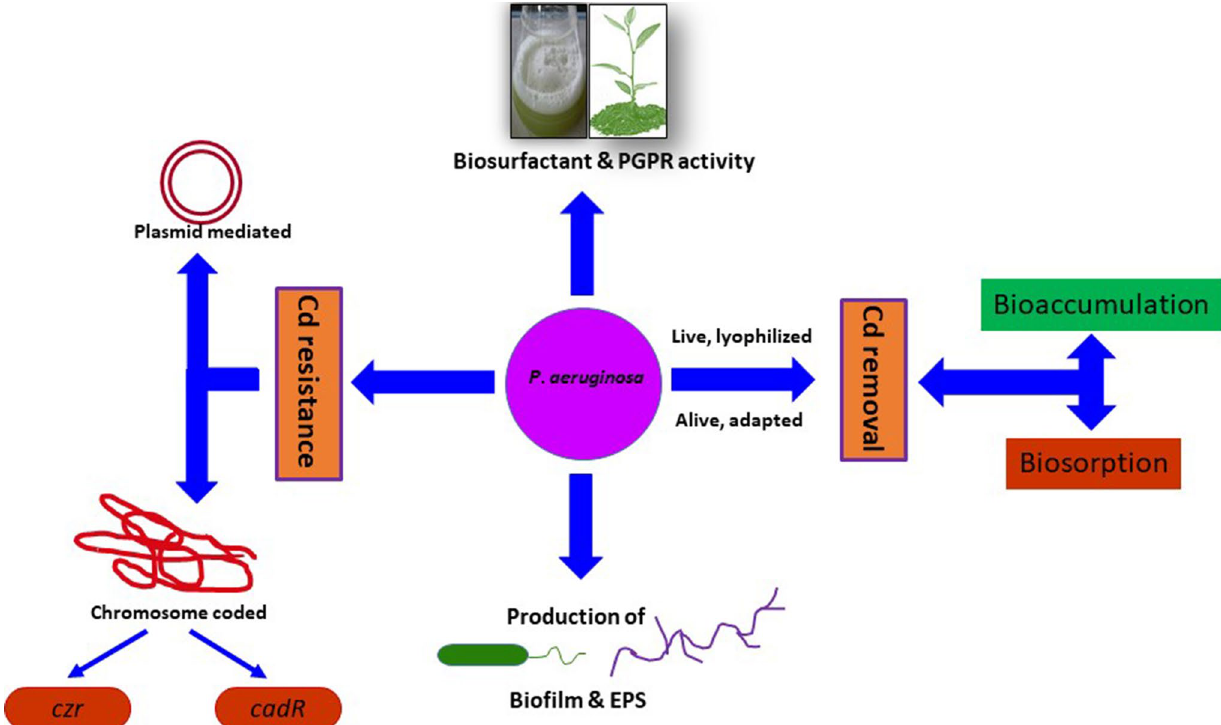
Fig. 1 Schematic representation of P . aeruginosa used in cadmium